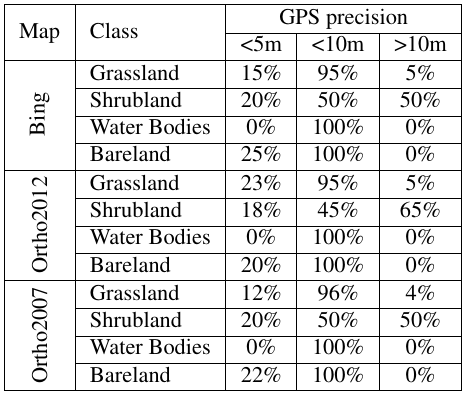
Table 10. Percentage of correctly classified points with respect